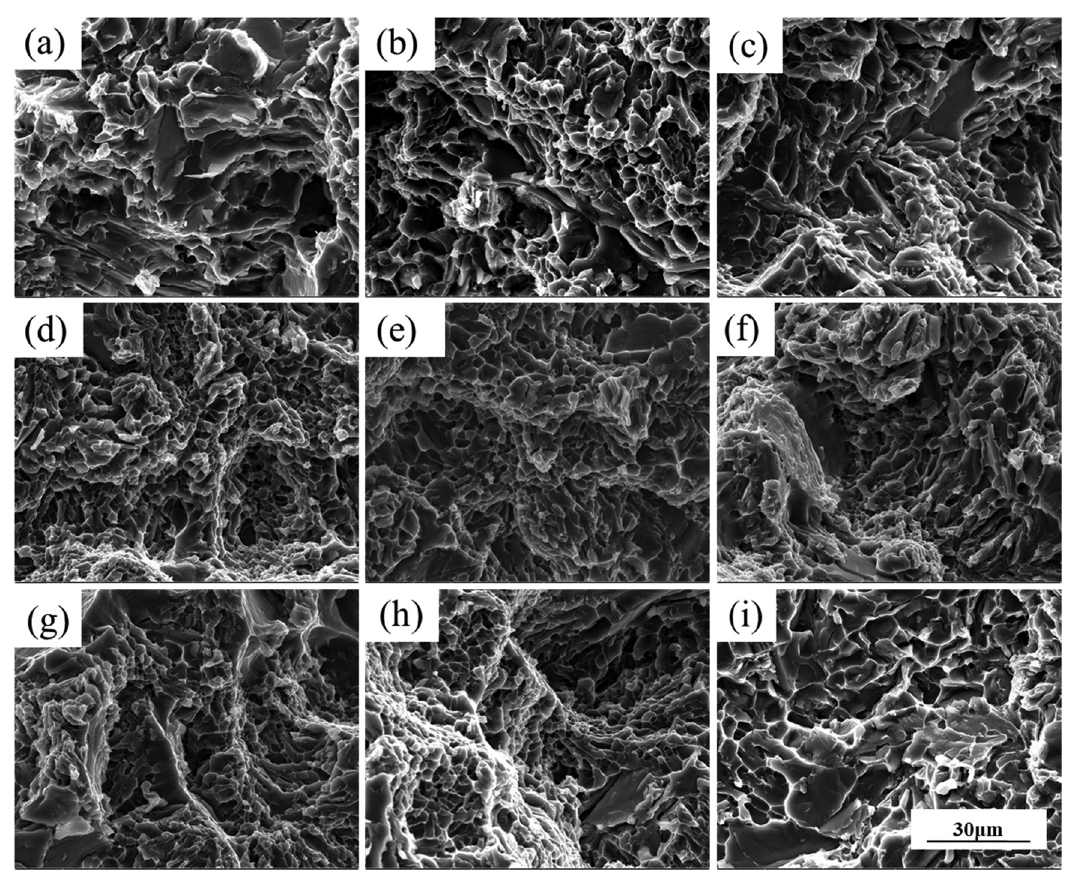
Figure 7: Appearance of tensile sample fracture: ( a ) Group 1, U 0 ; ( b ) Group 2, U 1 ; ( c ) Group 2, U 2 ; ( d ) Group 3, U 1 ; ( e ) Group 3, U 2 ; ( f ) Group 4, U 1 ; ( g ) Group 4, U 2 ; ( h ) Group 5, U 1 ; and ( i ) Group 5, U 2 .